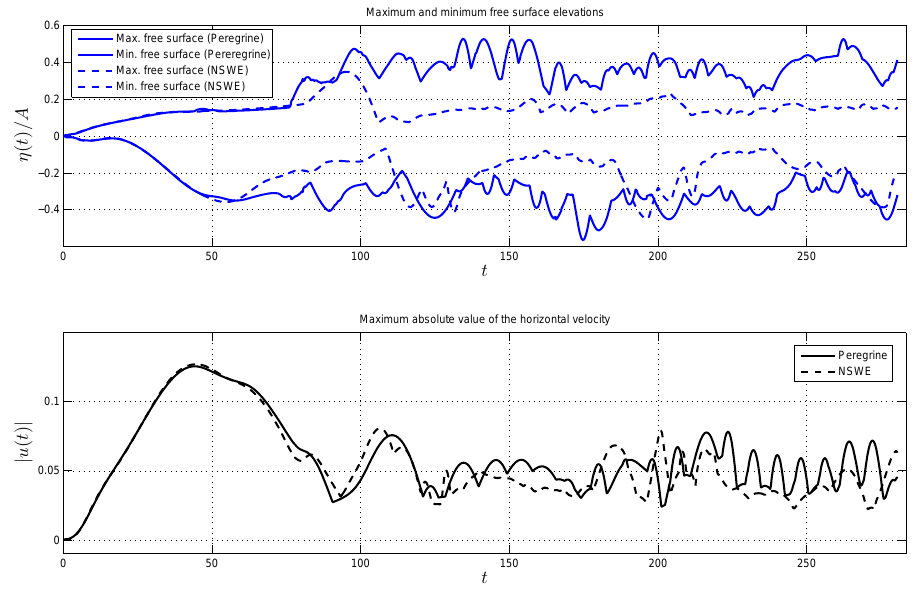
x = 120.0 Peregrine NSWE Figure 12. Time series of the surface elevation at wave gauges located at x = 40 , x = 60 , x = 80 , x = 100 and x = 120 . The solid (blue) curve depicts the wave elevation computed with the dispersive system (3.2) , and